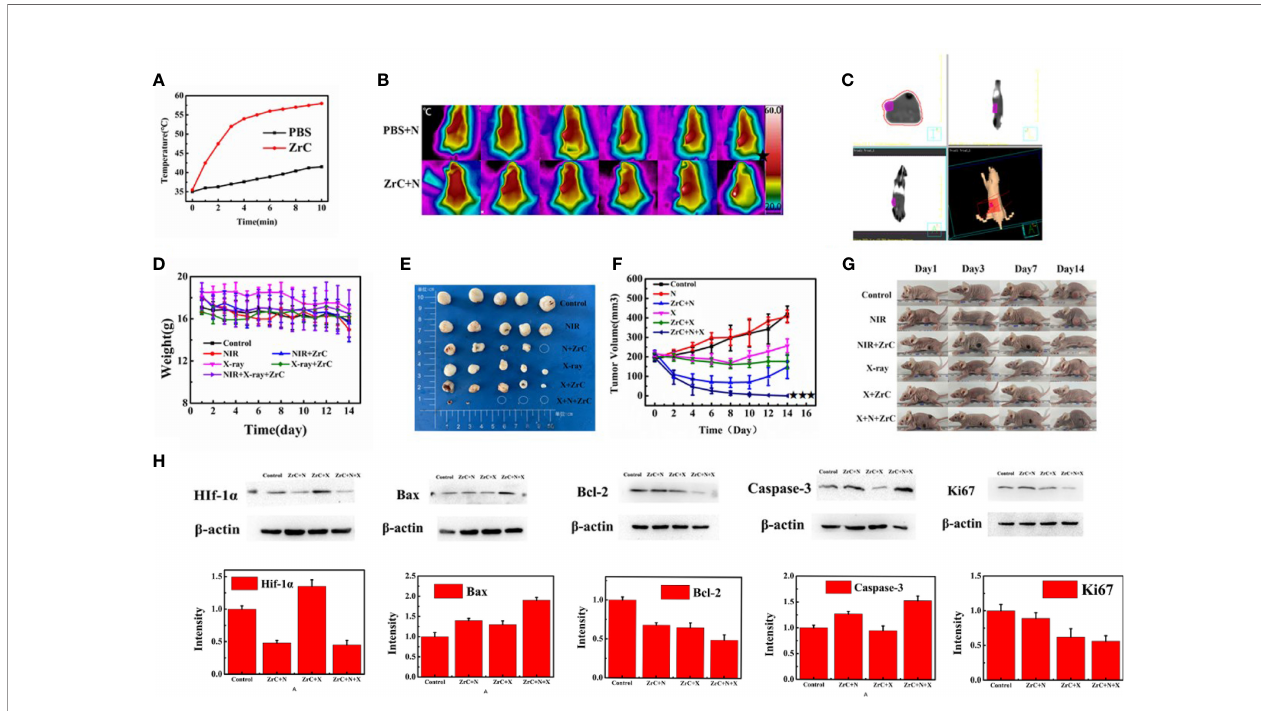
FIGURE 4 | (A) The temperature curves of the tumor site after they were intravenously injected with ZrC NPs (dose 0.5 mg mL-1, 200 µL) and PBS, respectively, and then exposed to an 808 nm NIR laser (1.5 W cm-2, 10 min); (B) Infrared thermal images of tumor-bearing mice while PT. (C) RT plan for mice. (D) The variations in weight of mice in six groups. Error bars represent mean ± SD. (E) Tumors were cut out at 14 days after treatment from fi ve mice in each group. (F) Tumor volume in six groups were measured after treatment. Error bars represent mean ± SD. (G) Representative photos of tumor-bearing mice after 14 d treatment. (H) In control, NIR(PT), ZrC+N (PT+ZrC NPs), X-ray (RT), ZrC+X (RT+ZrC) and ZrC +N+X (RT+PT+ZrC NPs) groups, respectively. Protein expression measured by Western Blot of HIF-1a/Bax/Bcl-2/Caspase-3/Ki67 and Intensity expression level of these